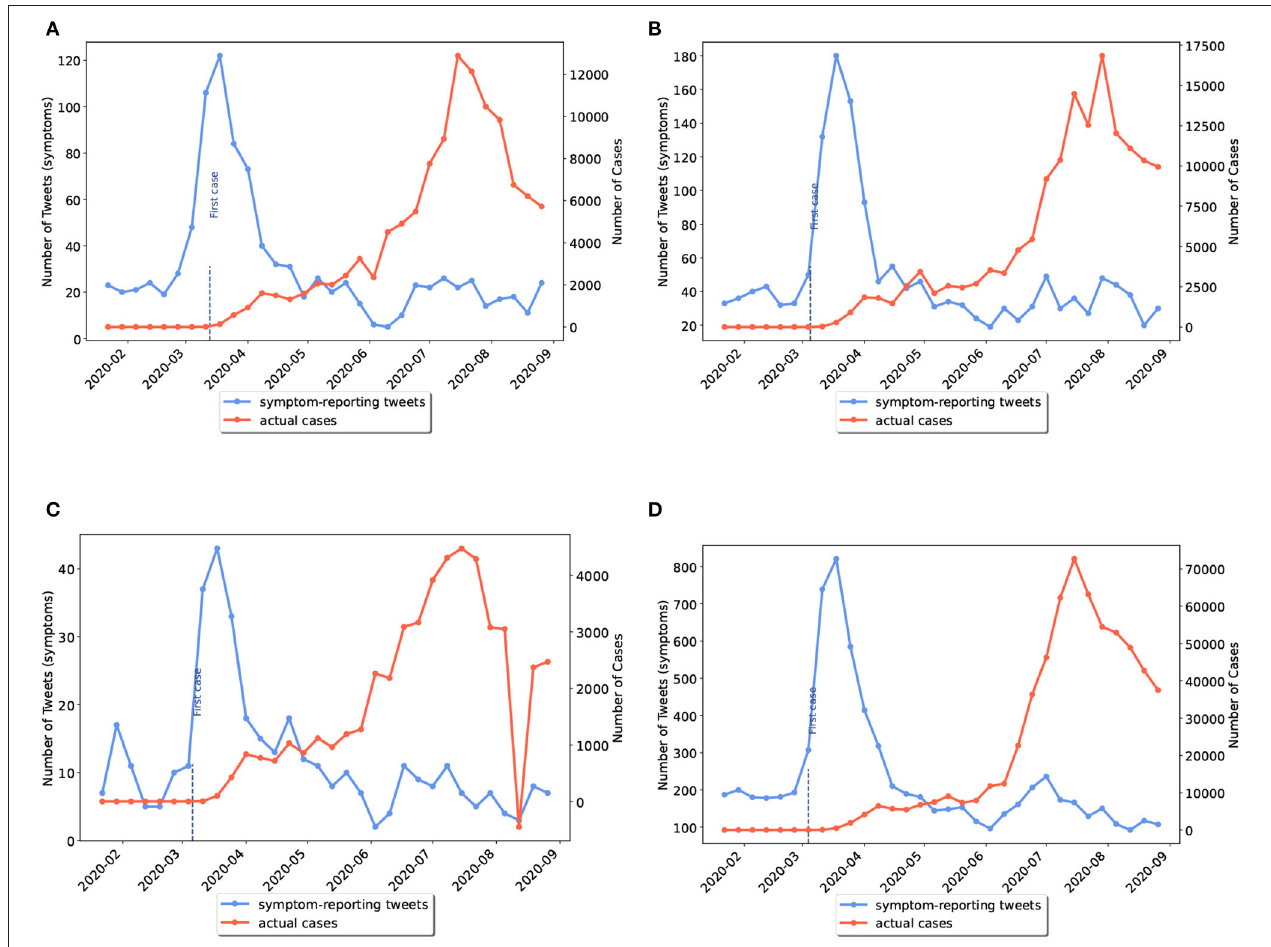
FIGURE 4 | Weekly comparison of symptom-related tweets and the actual number of cases in states with only the second wave of disease (category II). (A) Alabama, (B) Tennessee, (C) Utah, (D) Texas.